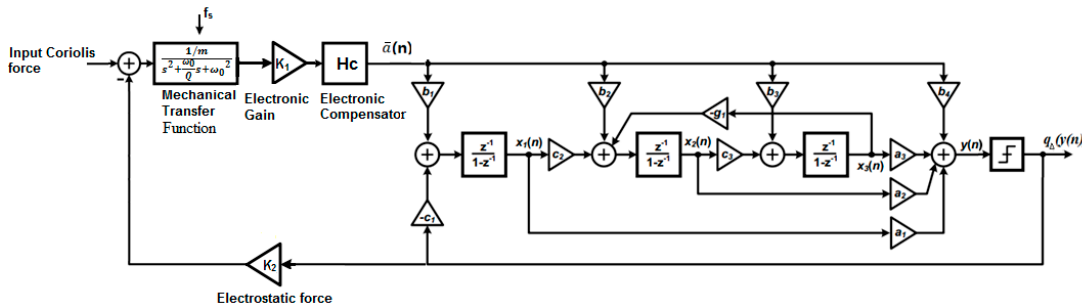
Figure 3. A third order 1-bit MEMS gyroscope with resonator.